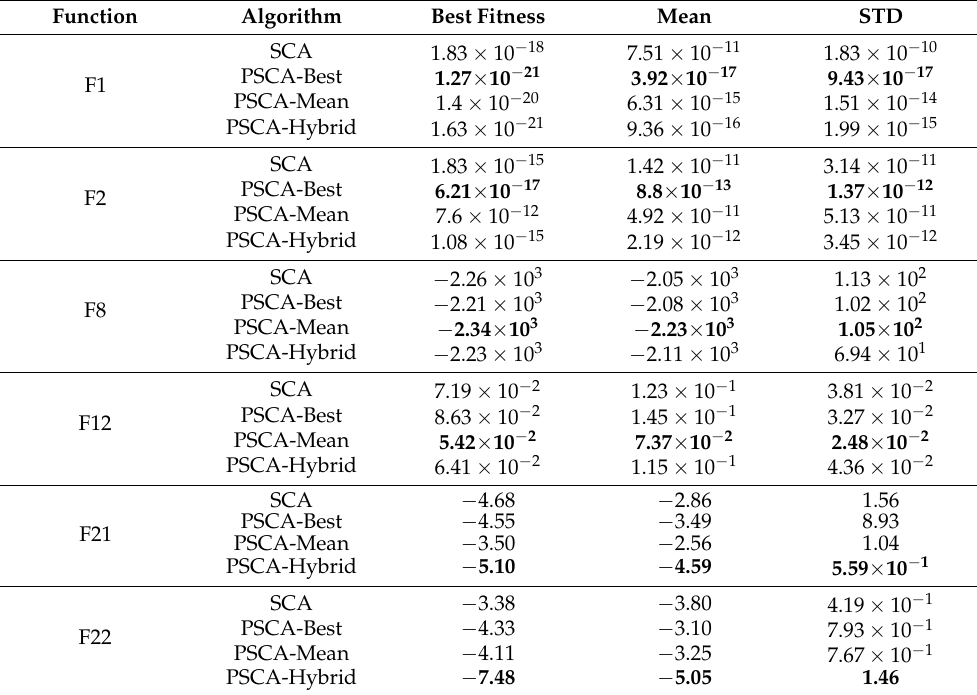
Table 4. The comparison test of the SCA, PSCA-Best, PSCA-Mean, and PSCA-Hybrid. Function